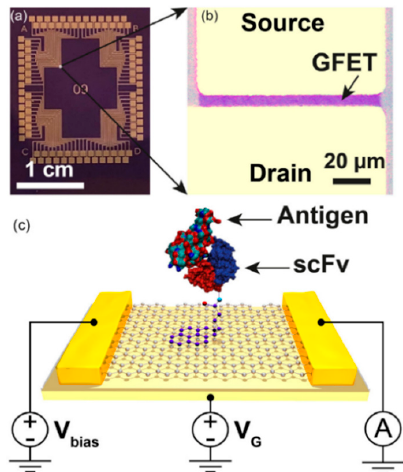
Figure 2. Graphene-based Field Effect Transistor (GFET) sensor showing ( a ) sensor array containing 100 GFET units, ( b ) optical micrograph of a single unit ( c ) visualization of the GFET with attached scFv binding to antigen. Reprinted from ref [37], with permission from IOP Publishing.